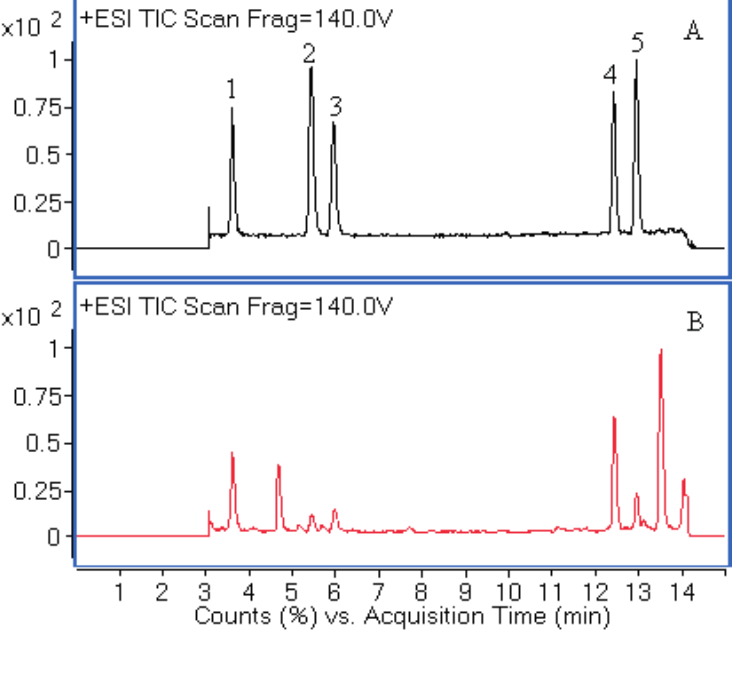
Figure 1. Liquid chromatography/quadrupole-time-of-flight mass spectrometry (LC-Q-TOF-MS) total ion chromatograms (TIC) of a mixture of five standards ( A ) and the extract of H. sabdariffa ( B ). Peaks 1 , 2 , 3 , 4 and 5 correspond to neochlorogenic acid, chlorogenic acid, cryptochlorogenic acid, rutin and isoquercitrin,